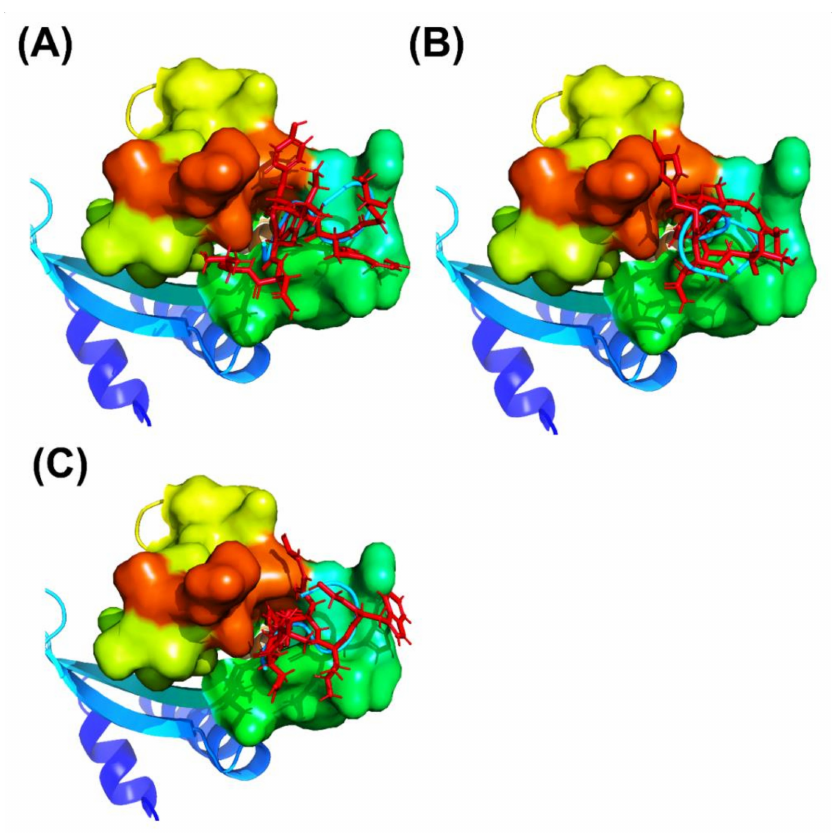
Figure 3. Overview of peptide docking conformations of the three cyclic peptides (cartoon model, cyan) obtained using ClusPro Dock are compared with the complex structures with the GaMD refinement (stick model, red): ( A ) CP1, ( B ) CP2, and ( C ) CP3.